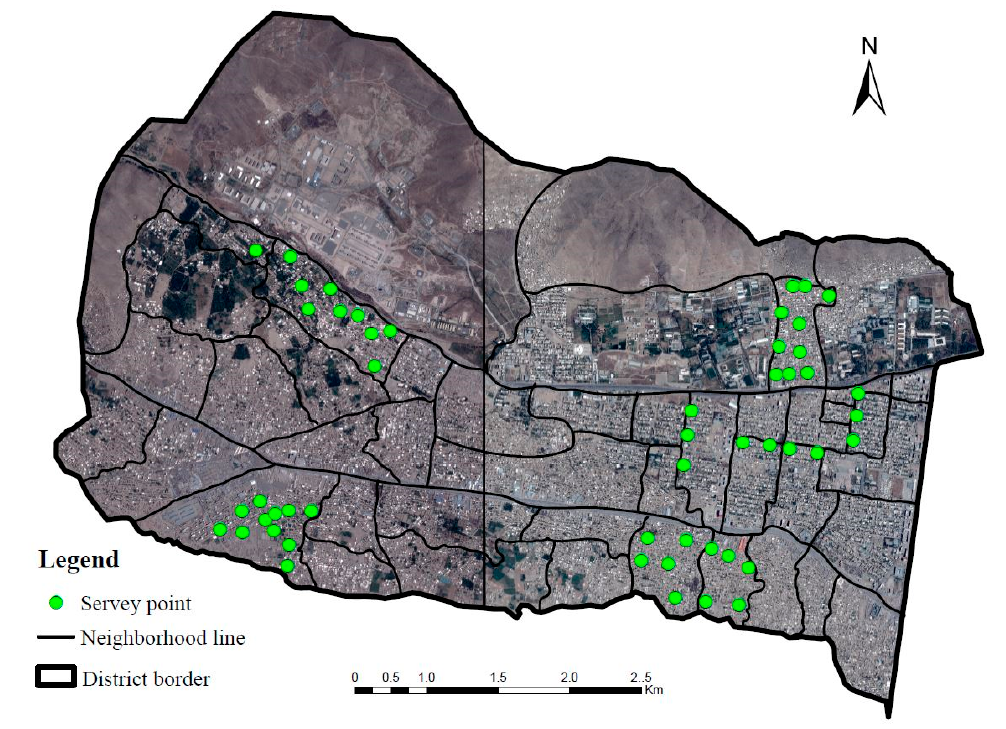
Figure 3. Map of District 5 with neighborhood boundaries and investigated sites.